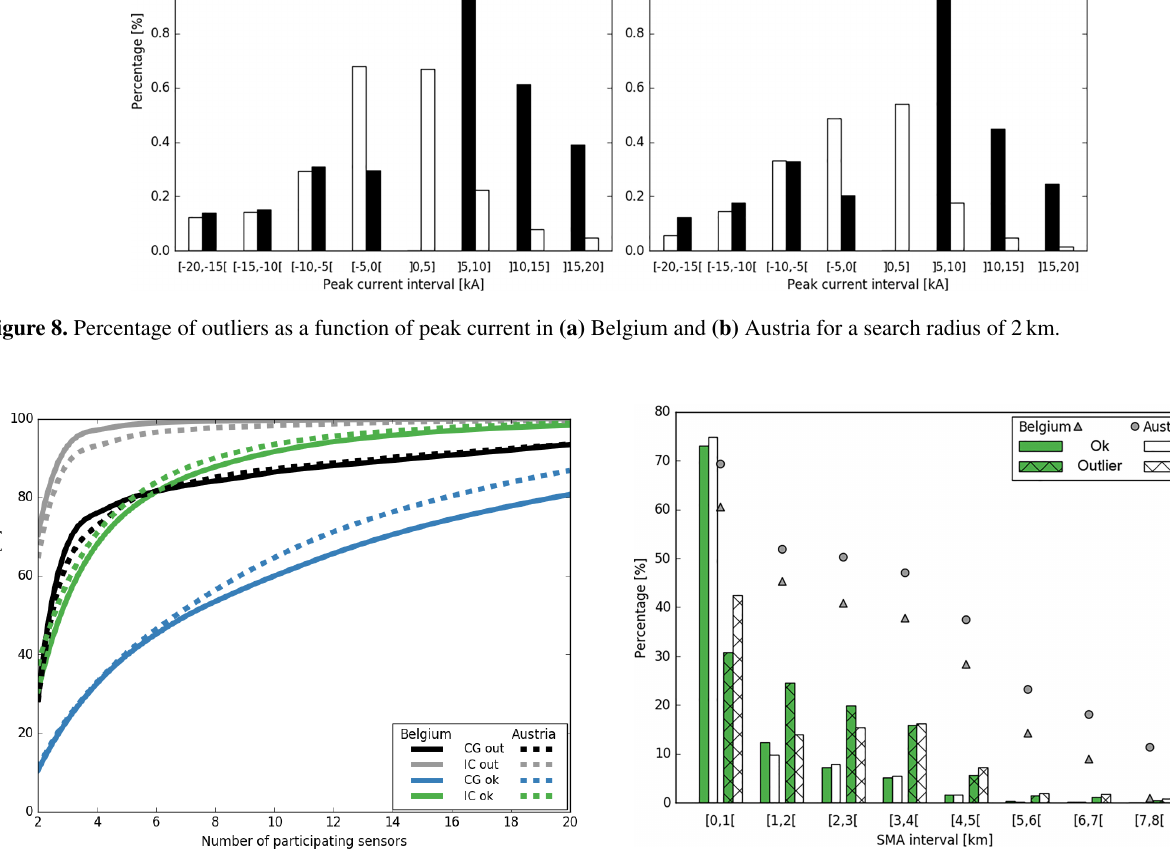
Figure 9. Cumulative distribution of the number of sensors partic- ipating in a solution for CG and IC outliers (“out”) and correctly located (“ok”) events.